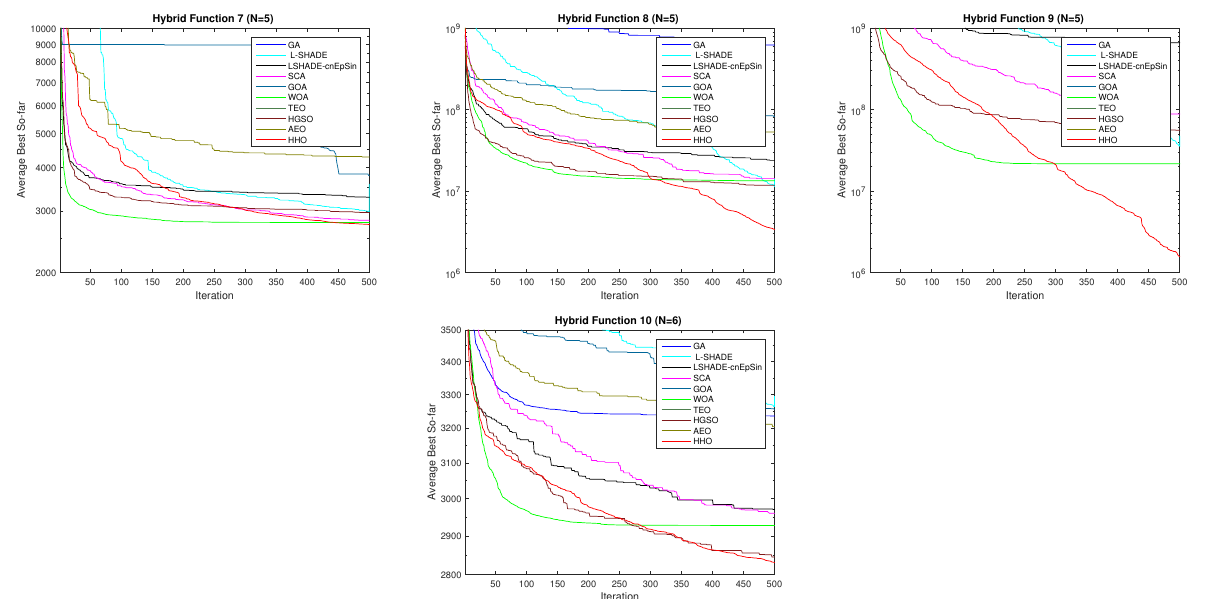
Figure 7. Convergence curve for HHO against other competitors from F11–F20 CEC2017.